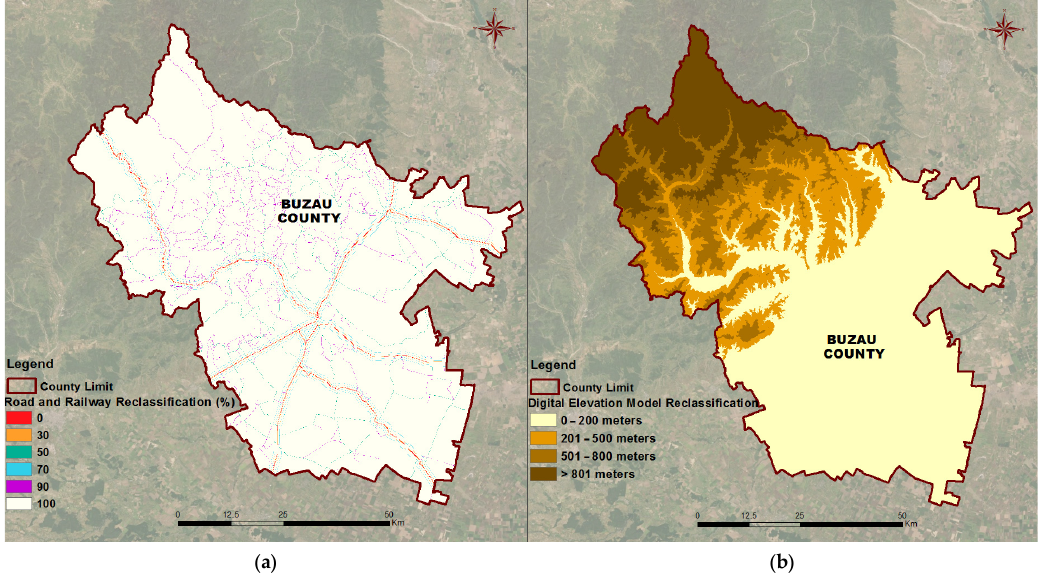
Figure 7. Results obtained by rasterization and standardization of the input datasets for the following habitat factors: ( a ) Roads and railroads . For the reclassification, we have obtained the map of travel restrictions for the brown bear movement. Most barriers are represented by the national roads and railroads of the county (the county and communal roads in the northern part are not real barriers due to their poor quality which results in restricted and low traffic on these secondary roads); ( b ) Digital Elevation Model (DEM) . The occurrence of the brown bear is higher in the northern part of the county, at altitudes starting with 300 m. After reclassification, the map shows that the brown bear habitat is present in the northern part of the county, which is favorable for the brown bear presence (maps created by the